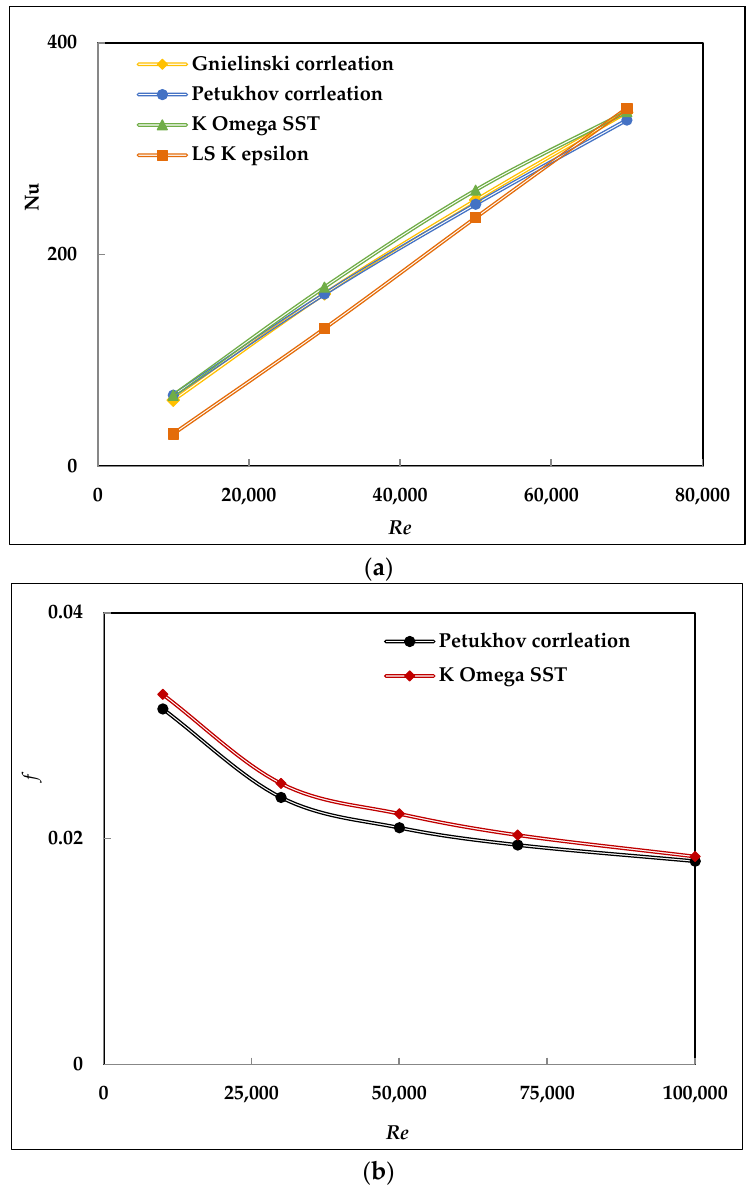
Figure 5. Comparisons between the present work with the experimental correlations ( a ) Average Nusselt number correlations proposed by Petukhov [34] and Gnielinski [35] ( b ) Friction factor, f , correlation proposed by Petukhov [34].